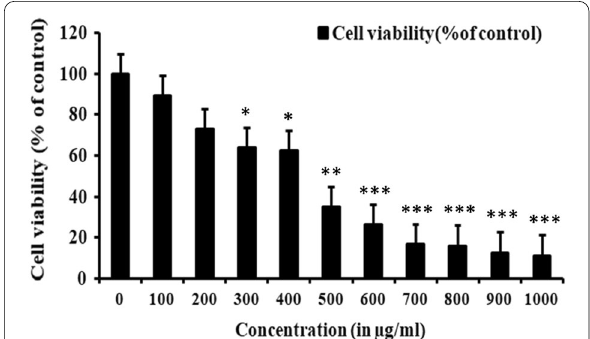
Fig. 2 Effect of GME on cell proliferation and viability of RAW 264.7 cells. Cells were treated with increasing concentrations of extracts for 24 h; cell viability was determined with MTT cell proliferation reagent. Results were expressed as cell viability (% of control). All data are